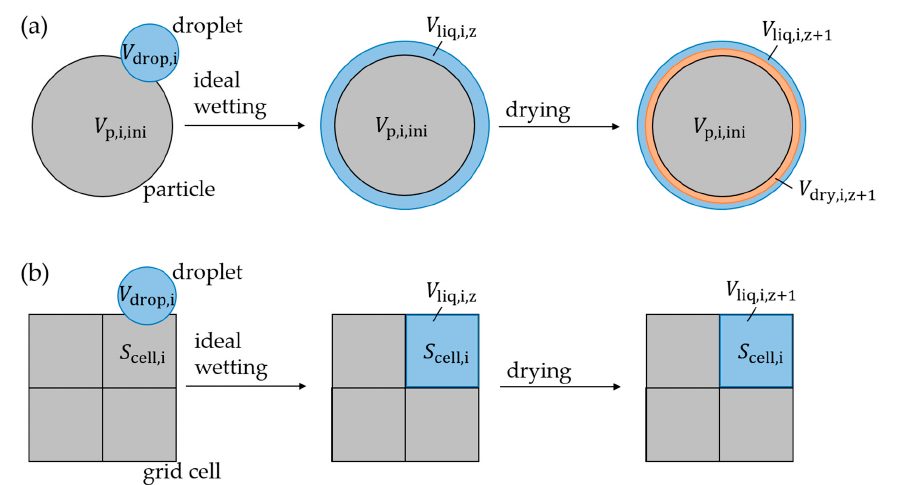
Figure 2. Schematic of the coating model: Droplet hits a particle ( a ) and droplet hits a cell of the wall grid ( b ).